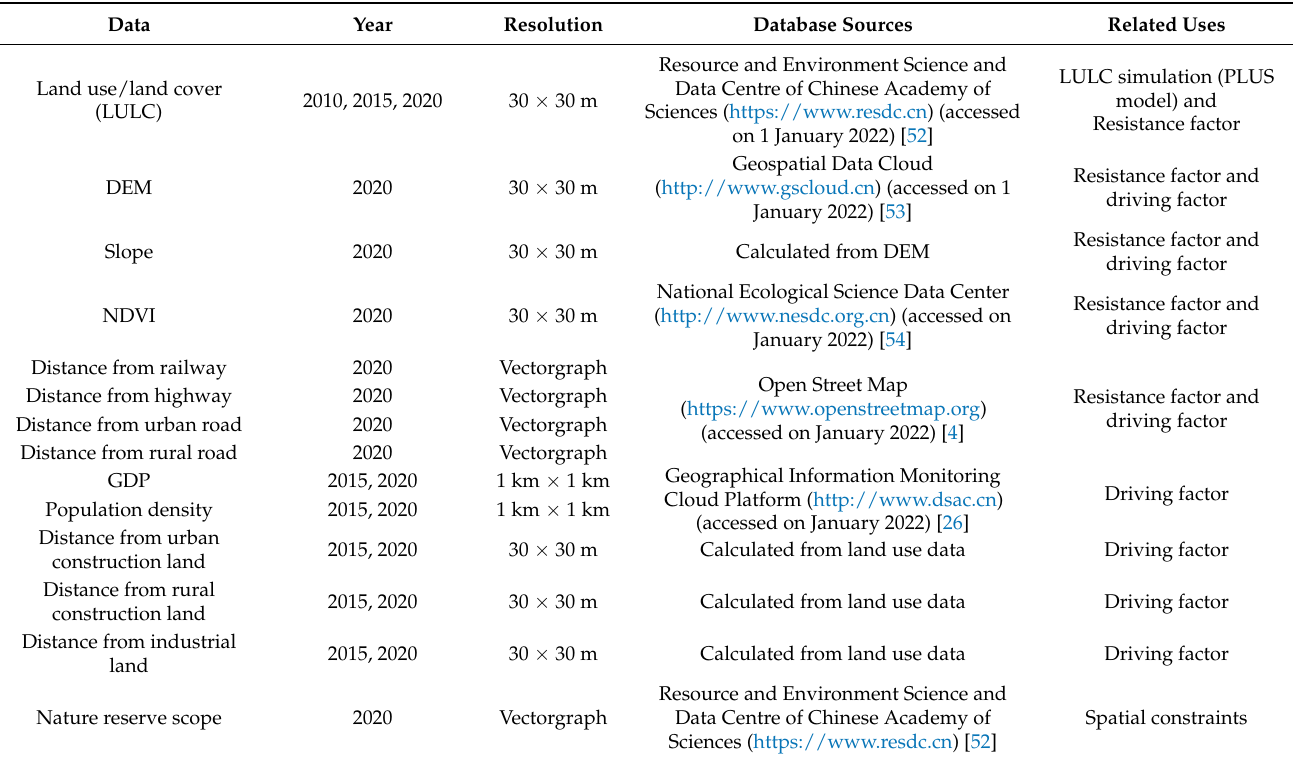
Table 1. Information on the data used in this